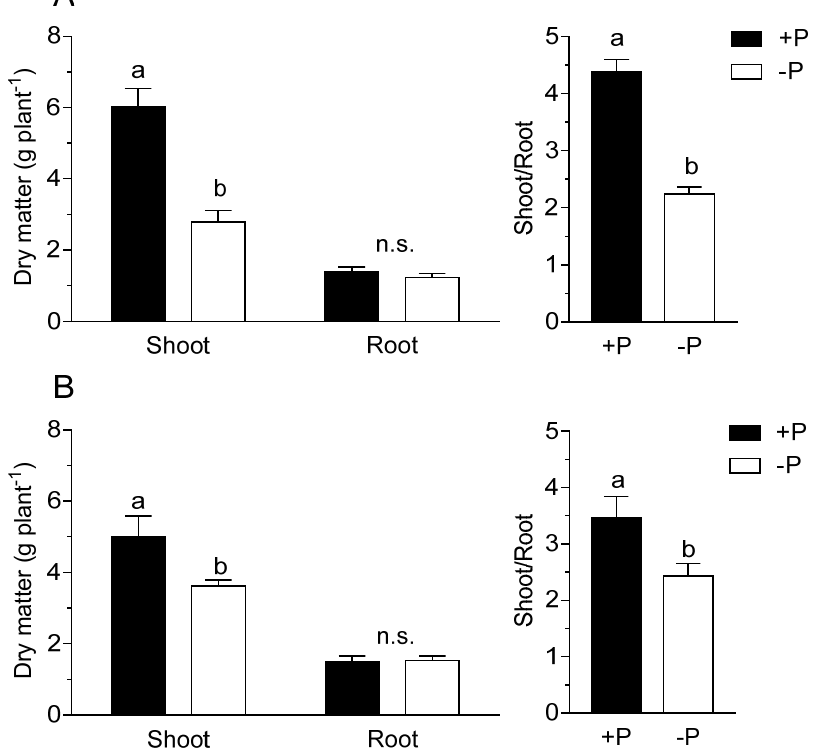
Figure 4. Plant dry matter and shoot/root ratio of ( A ) sunn and ( B ) wild-type plants at the end of the P-depletion experiment. +P stands for sufficient P supply and − P for a three-week P-depletion treatment. Data are means of six replicates ± SE. Lower case letters indicate a significant difference between treatments ( t -test, p < 0.05, n = 6). n.s., not significant.